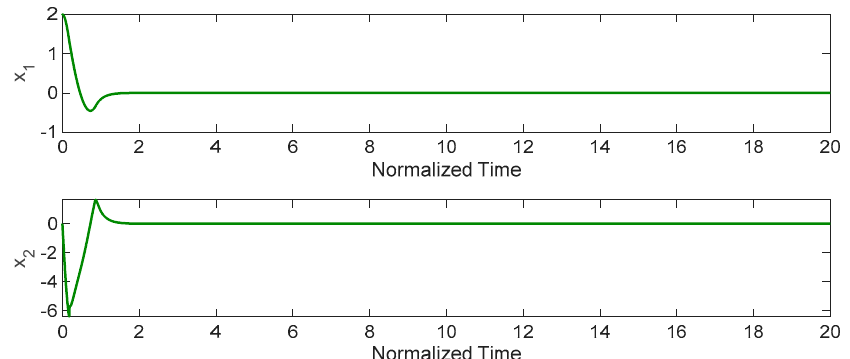
Figure 6. The states of the system based on the proposed control scheme in the presence of control input limitations.